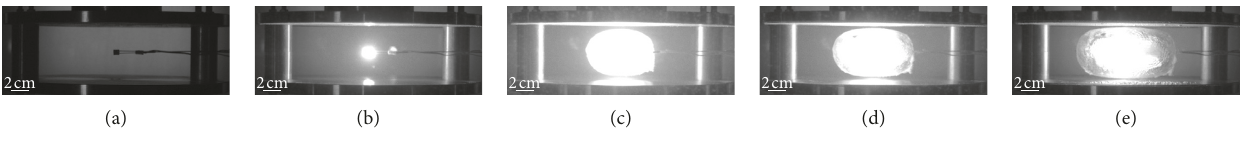
Figure 6: Evolution of the underwater explosion bubble’s expansion between the two coaxially and parallelly mounted plates by the explosive charge of 0 . 11 g. (a) t � 0.0000ms. (b) t � 1.7124ms. (c) t � 2.9324ms. (d) t � 3.5724ms. (e) t �